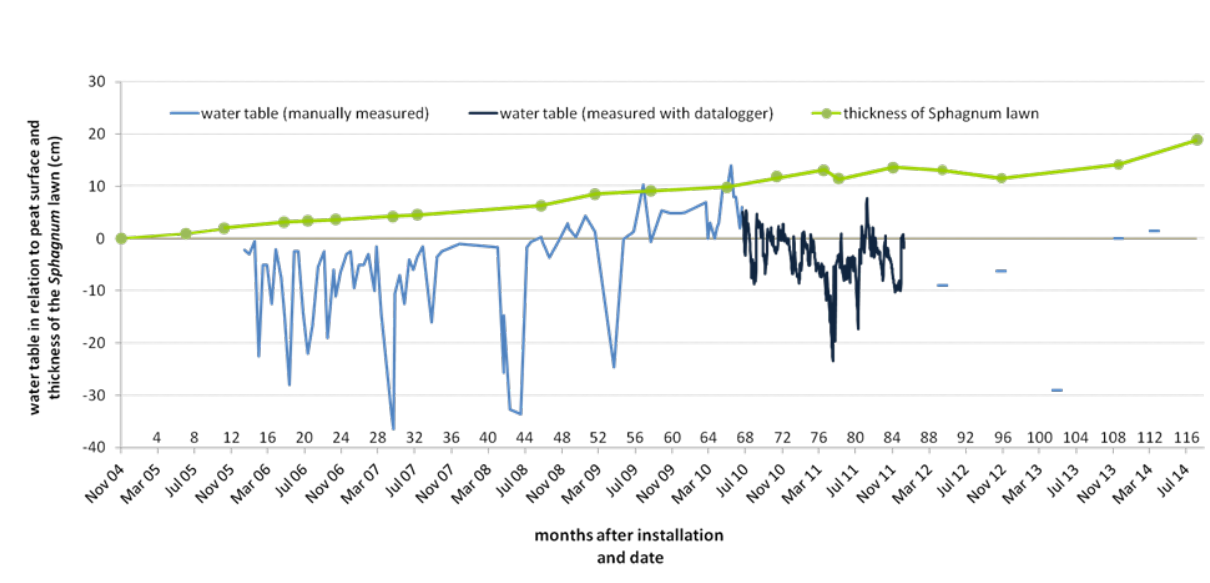
Figure 4. Fluctuations of water table relative to peat and peatmoss surface, and mean thickness (in cm) of Sphagnum lawn within 5 m of the water table measurement points. Water table position was determined manually (light blue) in the most northernmost well (near the datalogger) or by datalogger (dark blue, Beyer & Höper 2015). For locations of the measurement points see Figure 2. Water table data from 2012 onwards are shown as discrete points because measurements were made on only two occasions per